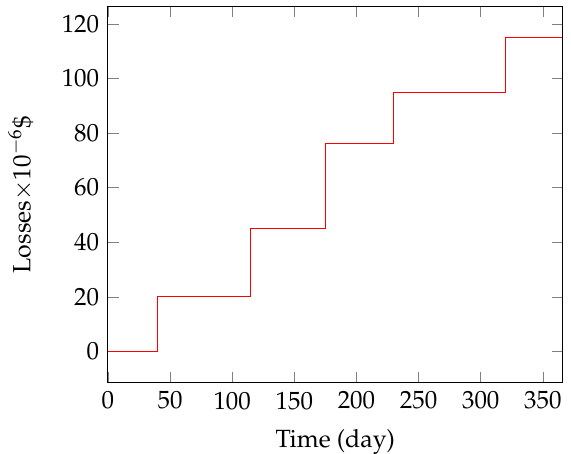
Figure 5. Example of the dynamics of X ( t )